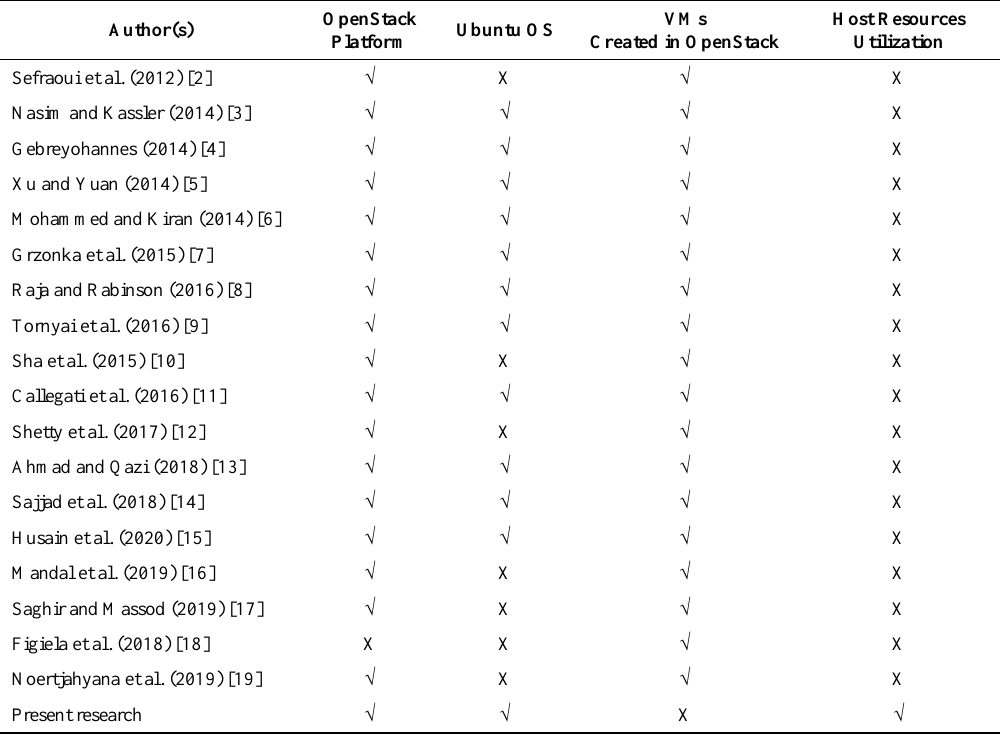
Table 5. Comparison of existing cases in